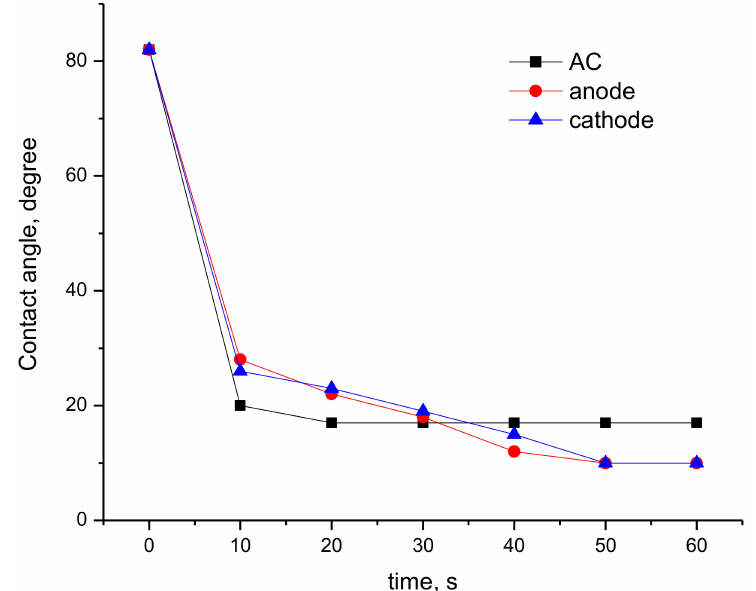
Figure 1. Dependence of contact angle of wettability as a function of treatment time using AC- and DC-discharge. Curves for DC-treated films are adapted by permission from Springer Nature: Springer Nature, High Energy Chem., Piskarev MS, Gilman AB, Gatin AK, Gaidar AI, Kurkin TS, Kuznetsov AA, Copyright